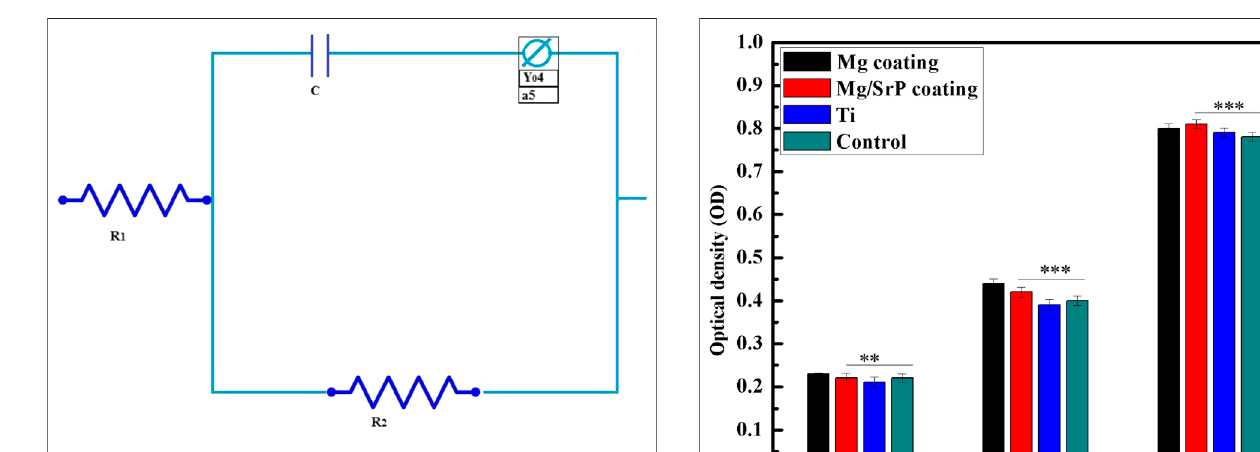
FIGURE 6 | Equivalent circuit of Mg and Mg/SrP coating immersed in D-Hank ’ s solution.